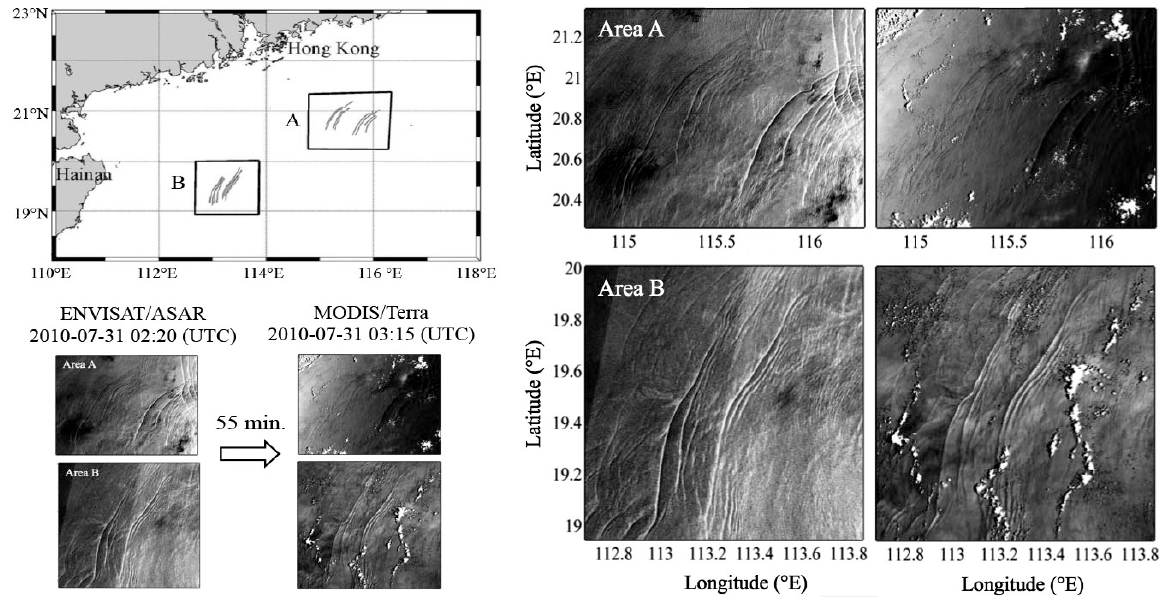
Figure 8. Left: ENVISAT–ASAR and MODIS–Terra images of the South China Sea acquired on 31 Figure 8. ENVISAT-ASAR and MODIS-Terra images of the South China Sea acquired on 31 July July 2010 with 55 minutes time difference. Two tidally generated internal wave packets are sepa- 2010 with 55 min time difference. Two tidally generated internal wave packets are separated by the rated by the distance proportional to the semi–diurnal tidal period [64]. distance proportional to the semi-diurnal tidal period